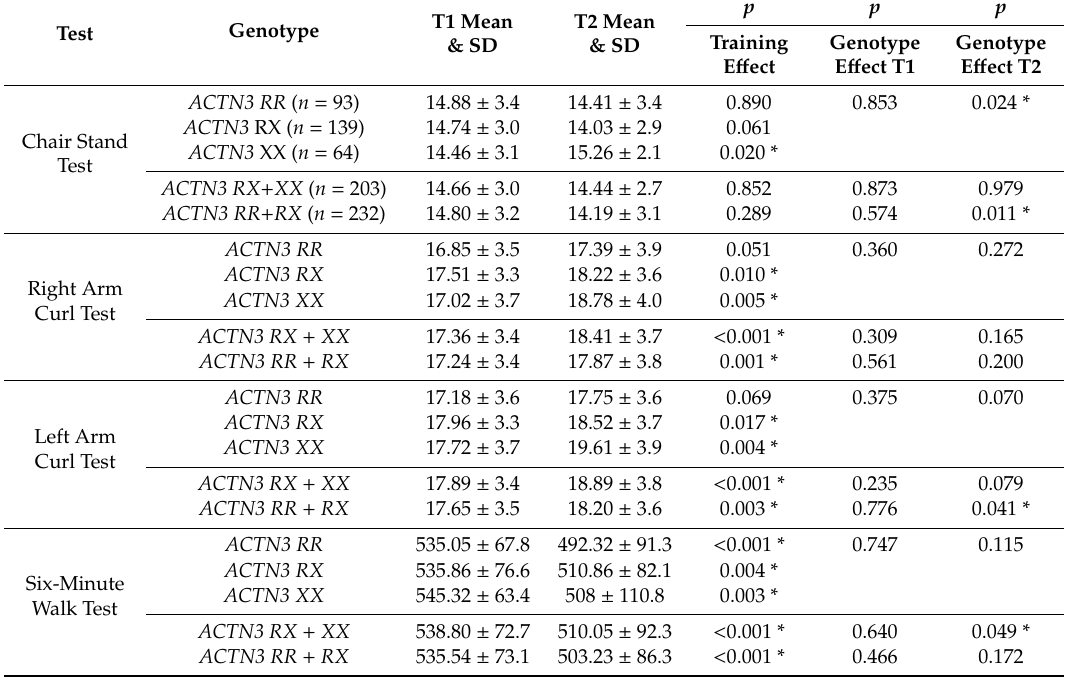
Table 2. Physical tests at baseline and after training and its association with training and ACTN3 genotypes.